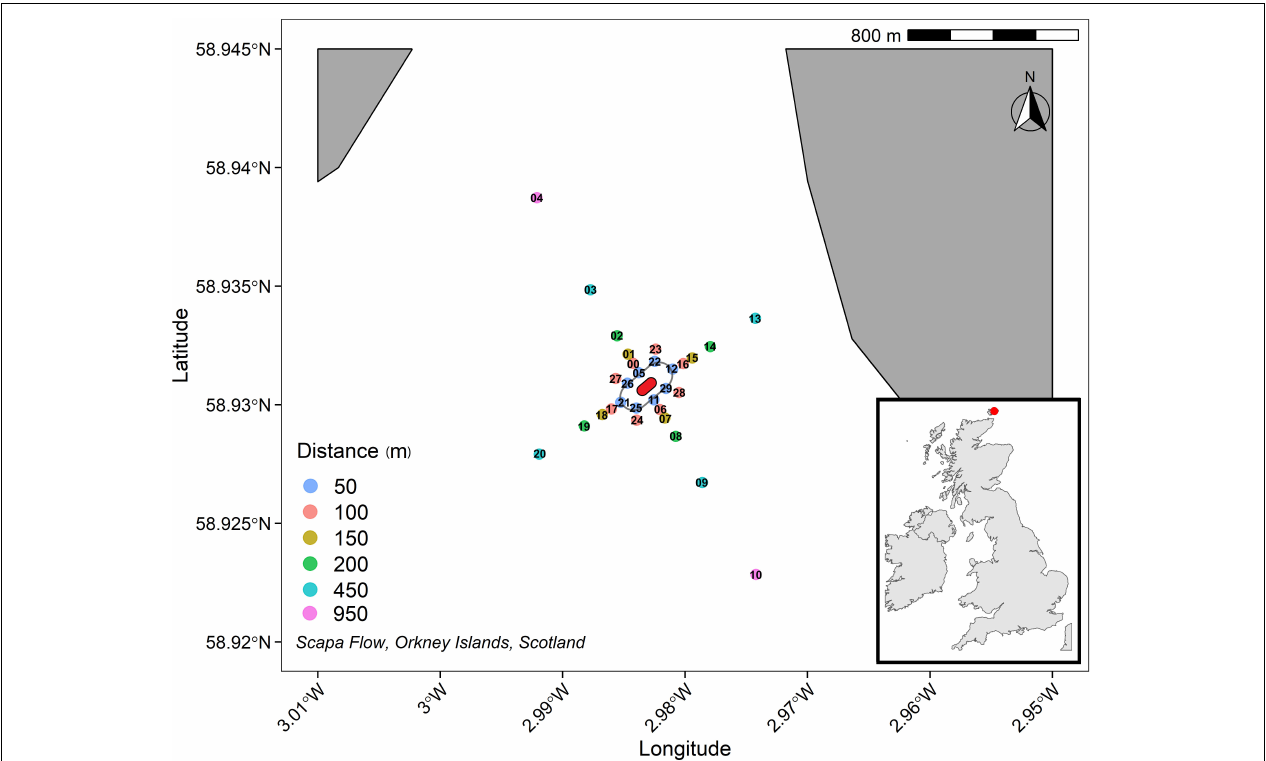
FIGURE 1 | 950 m cruciform transect (where those sediments sampled further away act as controls) centred on HMS Royal Oak shipwreck (approximation, centre, red), labels refer to sample codes as detailed in Supplementary Table 1 . A safety boundary (grey oval) around HMS Royal Oak meant sediment sampling commenced 50 m from the